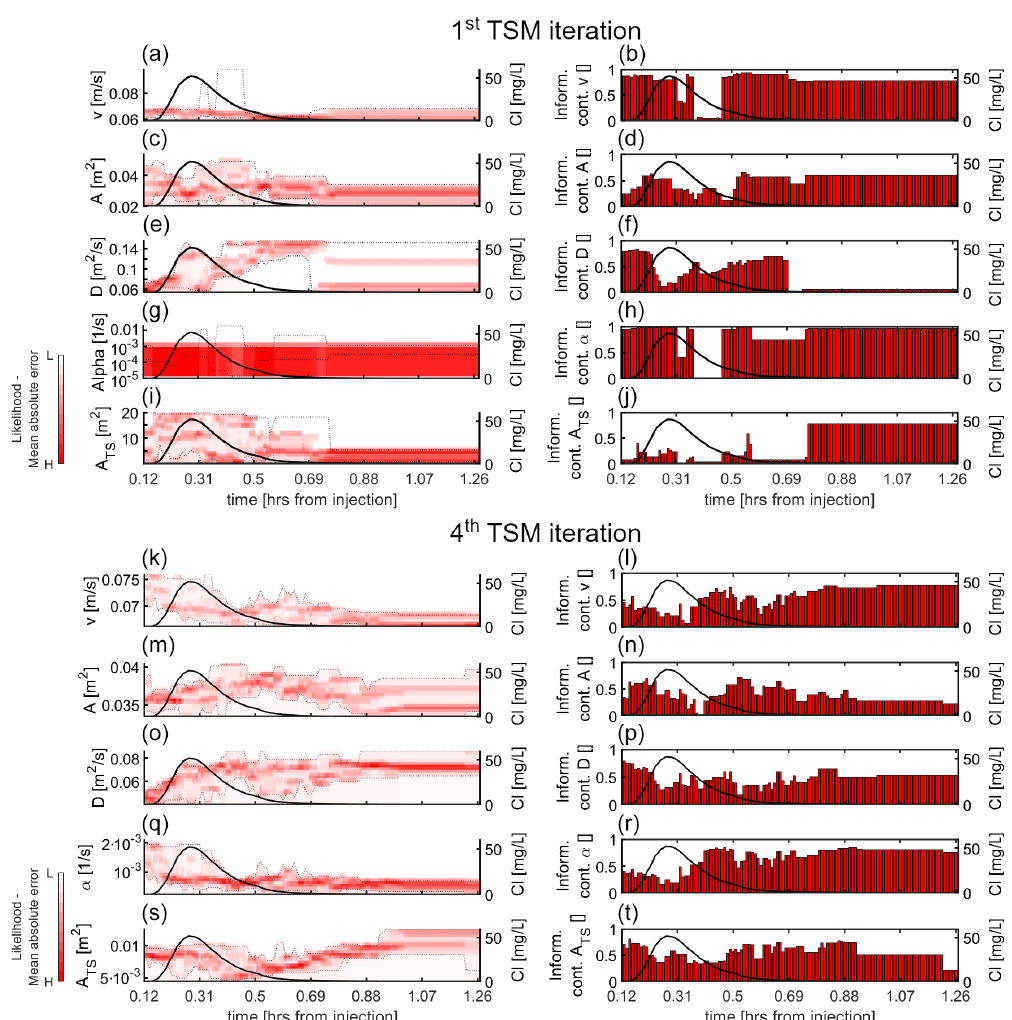
Figure 4. Dynamic identifiability analysis of model parameters for E1 when v was considered as a varying model parameter. Results report for the (a–j) first TSM iteration and the (k–t) last TSM iteration. (a, c, e, g, i, k, m, o, q, s) Likelihood distribution as a function of parameter values at each time step. Black lines indicate the observed BTC, and dashed black lines indicate the 90% confidence limits. Panels (b, d, f, h, j, l, n, p, r, t) indicate parameter information content (red bars) at each time step, while the black lines indicate the observed